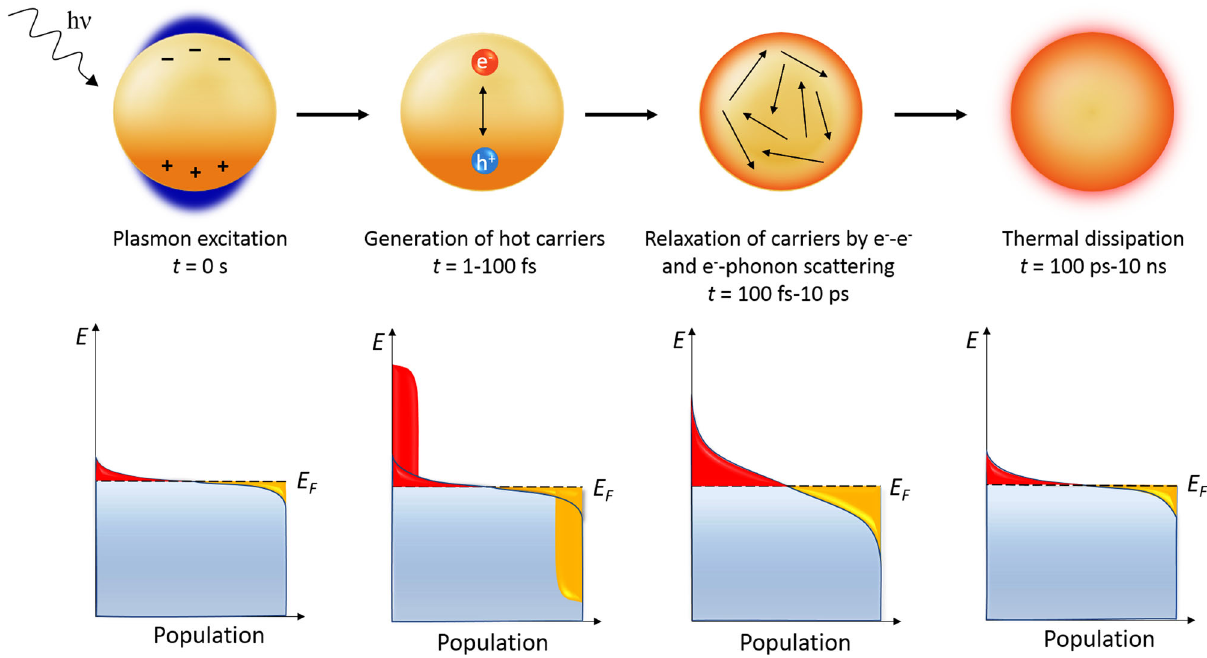
Fig. 2 Dynamics of plasmon decay and time evolution of charge carriers. Plasmon excitation at t = 0 and subsequent generation of athermal (not describable using Fermi-Dirac statistics) hot electron – hole pairs within the metal, then thermalization via electron – electron, electron – phonon scattering (this leads to a Fermi-Dirac distribution of charge carriers representing elevated temperature) and further via thermal dissipation via phonon – phonon scattering. E F indicates Fermi level, and yellow and red areas indicate holes and electrons energy, respectively. (Adapted with permission from ref. 24 Copyright © 2016, American Chemical